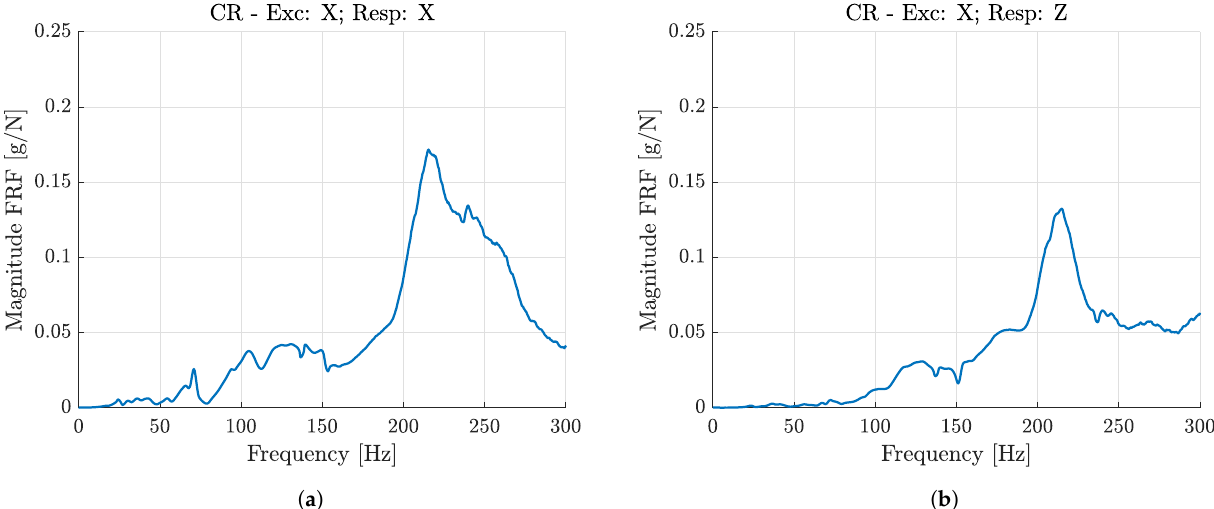
Figure 14. FRFs with the cutting head in the center-right (CR) position. Response in ( a ) X direction and ( b ) Z